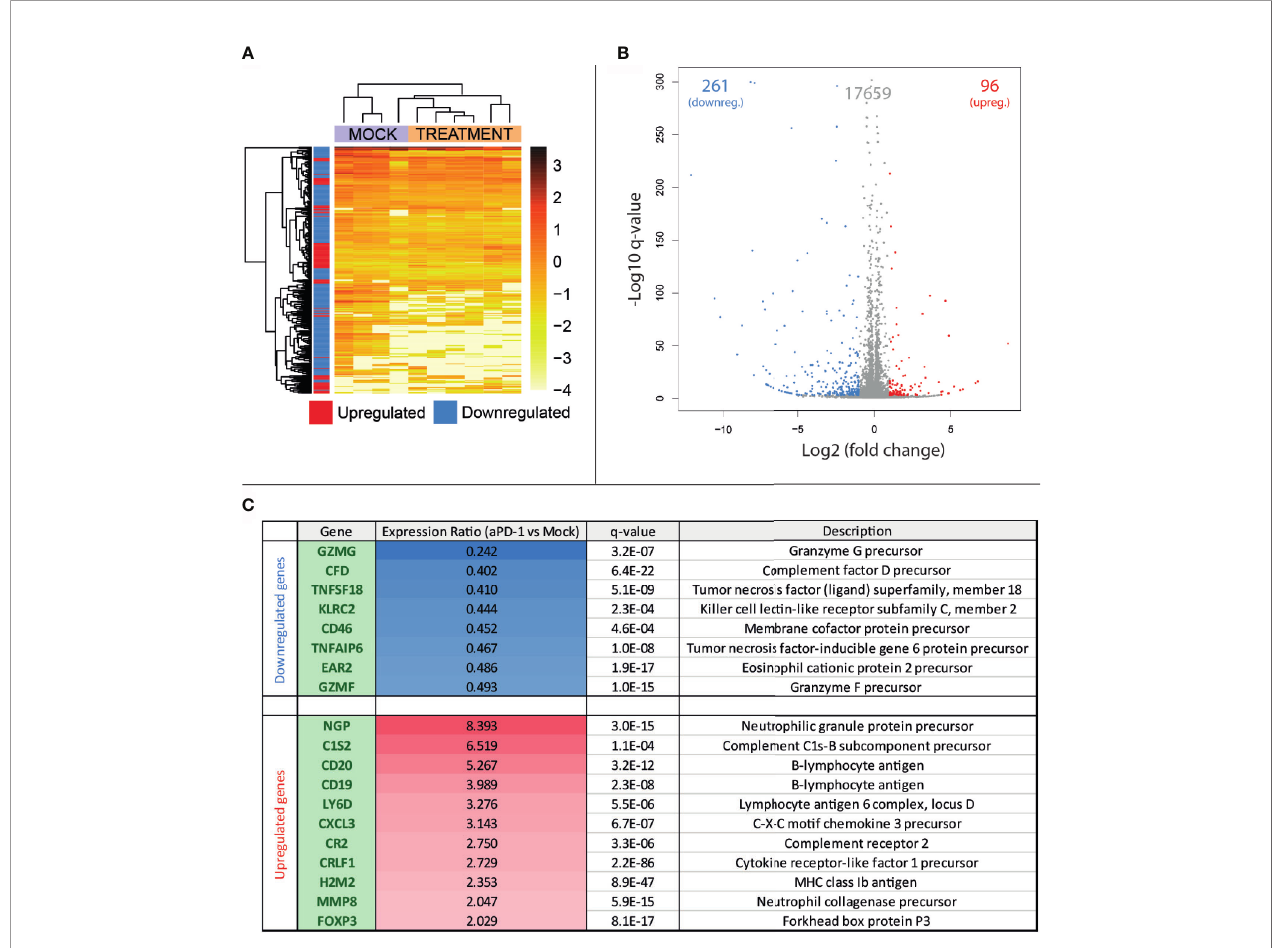
FIGURE 2 | Comparison at the gene expression level of treatment naïve progressing tumors and tumors progressing after aPD-1 therapy. Animals treated as described in Figure 1A were sacri fi ced and tumors harvested when they were considered refractory to aPD-1. RNA was extracted and expression pro fi les from both groups were compared. (A) Heatmap and unsupervised clustering of samples. (B) Volcano plot for the expression level comparison between treatment naïve and aPD-1 treated tumors. (C) Immune related signi fi cantly regulated genes. (Differences in gene regulations were taken into account if fold change was ≤ -2 or ≥ 2, with a q-value ≤